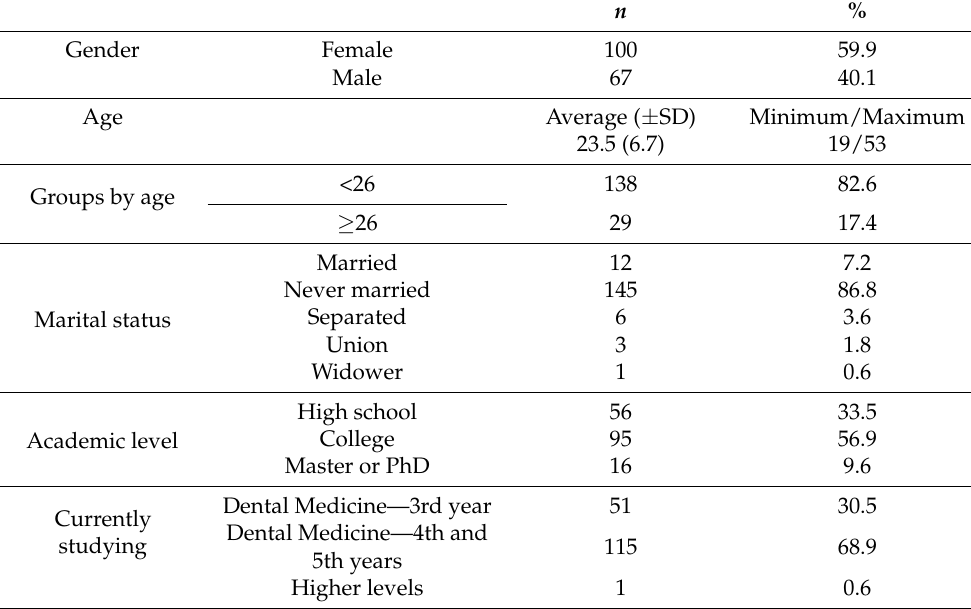
Table 1. Student sample characterization.